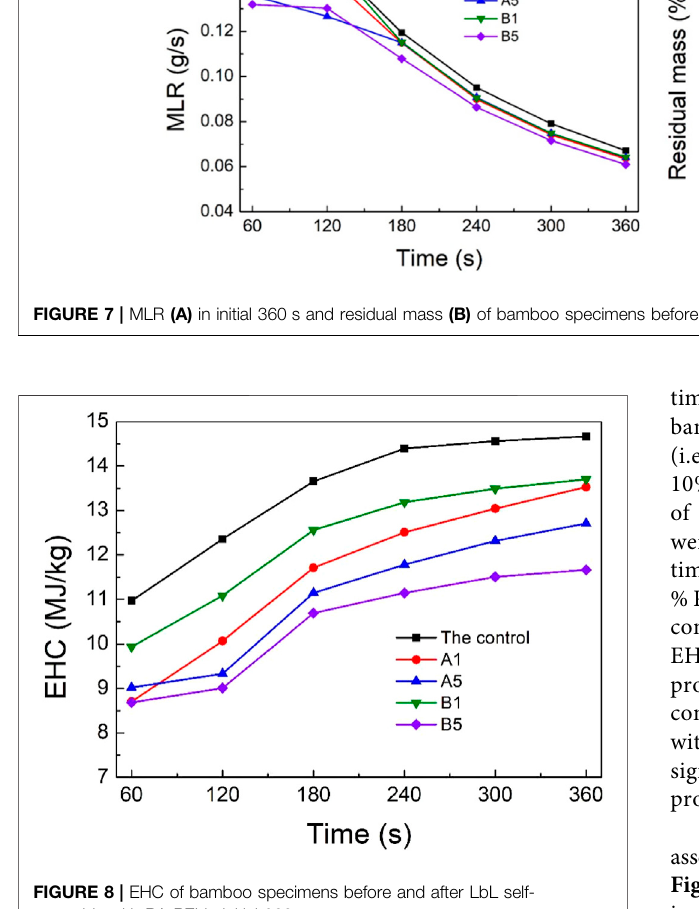
Frontiers in Materials |